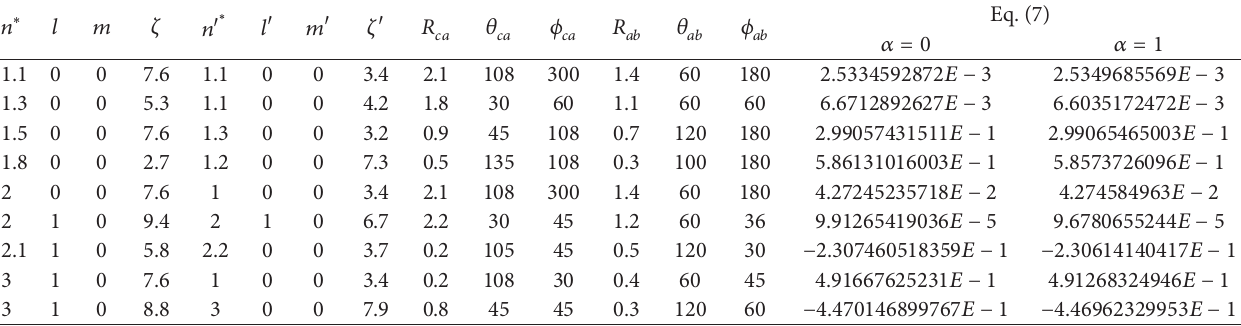
Table 1: Comparison methods of computing integer and noninteger SF three-center nuclear attraction integrals over STOs obtained in the molecular coordinate system for 𝑁 = 15 (in a.u.).